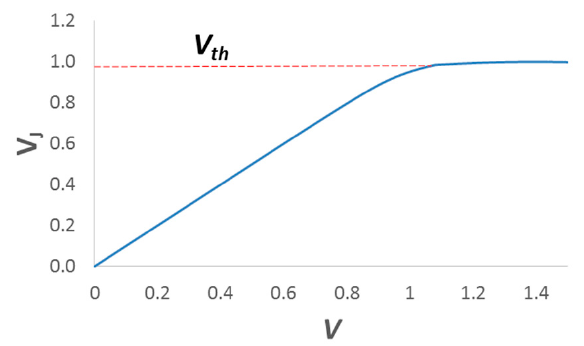
Figure 6. Plot of the internal voltage V J as a function of the applied voltage V . Internal voltage saturates at the threshold voltage V th .